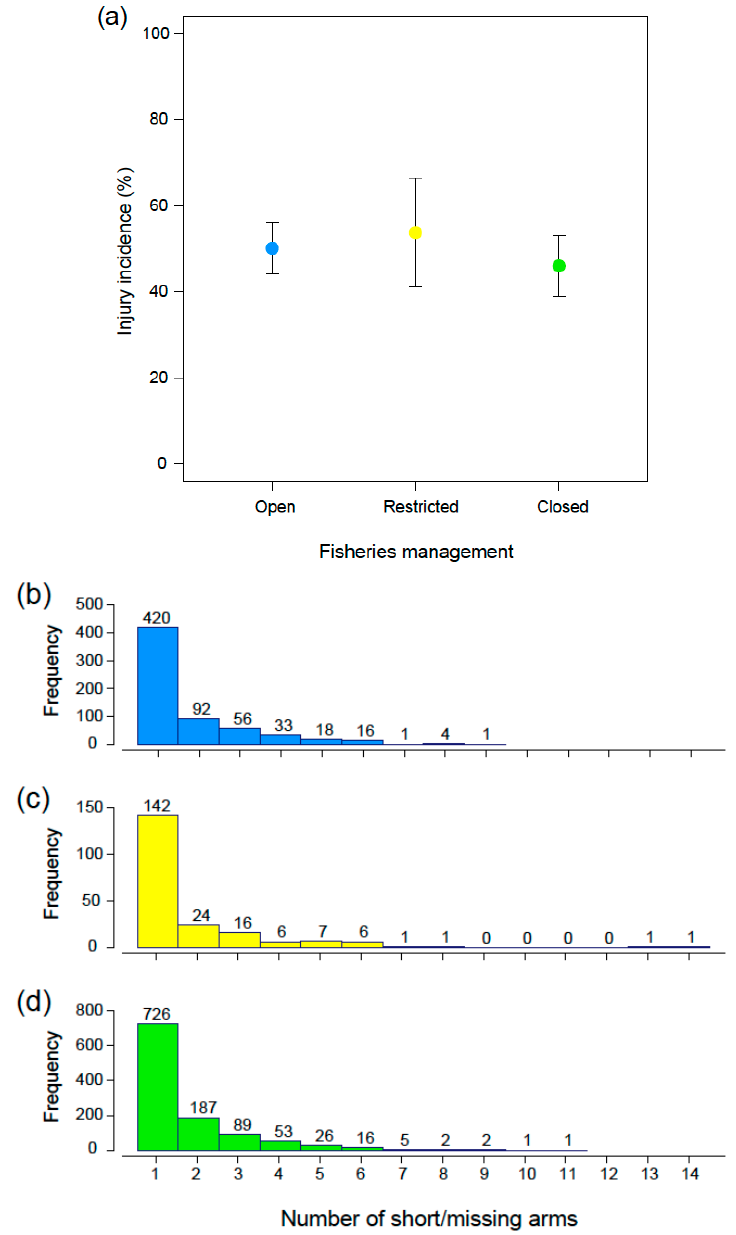
Figure 4. ( a ) Incidence of injury (percentage of individuals with damaged arms) averaged across the reefs in each of three different management zones (the colour of the circle designates fishing regulations: see ( b – d )); and ( b ) frequency distributions of short or missing arms for each zone (( b ) blue = open to fishing; ( c ) yellow = restricted fishing; ( d ) green = no fishing).